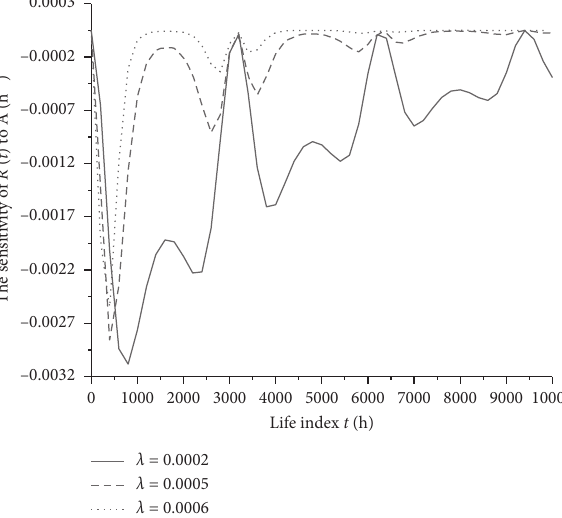
Figure 20: The sensitivity of R ( t ) to A ( λ �